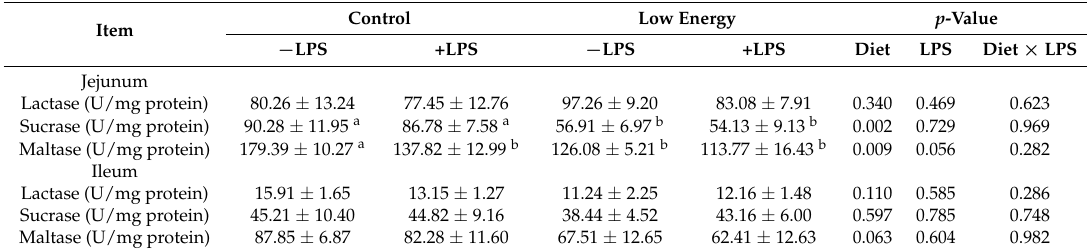
Table 8. Effect of different energy levels during gestation on intestinal enzyme activity of weaning piglets challenged with Escherichia coli lipopolysaccharide.